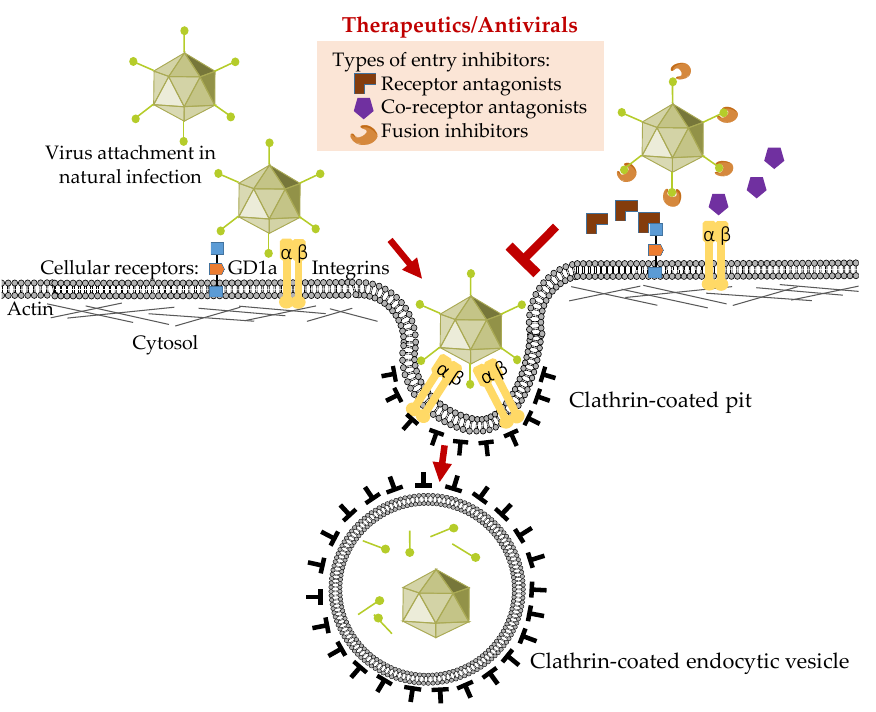
Figure 1. Schematic representation of the adenovirus entry process in corneal epithelial cells and possible viral entry inhibitors.